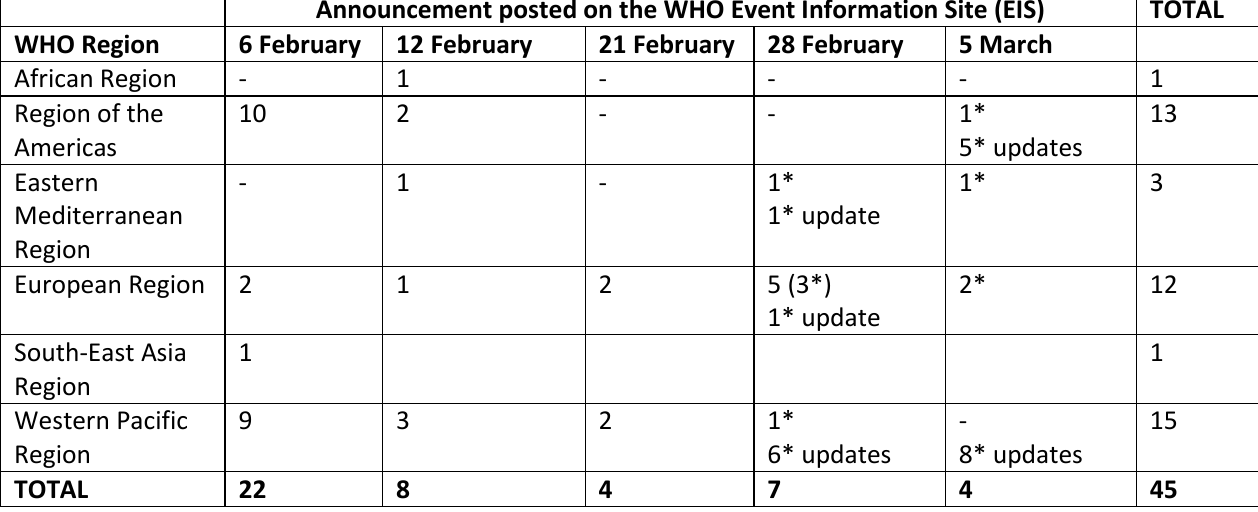
Table 1. Number of States Parties officially reporting additional health measures that significantly interfere with international traffic (i.e. more than 24h delay), under Article 43 of the IHR (2005) (by WHO region) Announcement posted on the WHO Event Information Site (EIS) TOTAL WHO Region 6 February 12 February 21 February 28 February 5 March 1 - - -